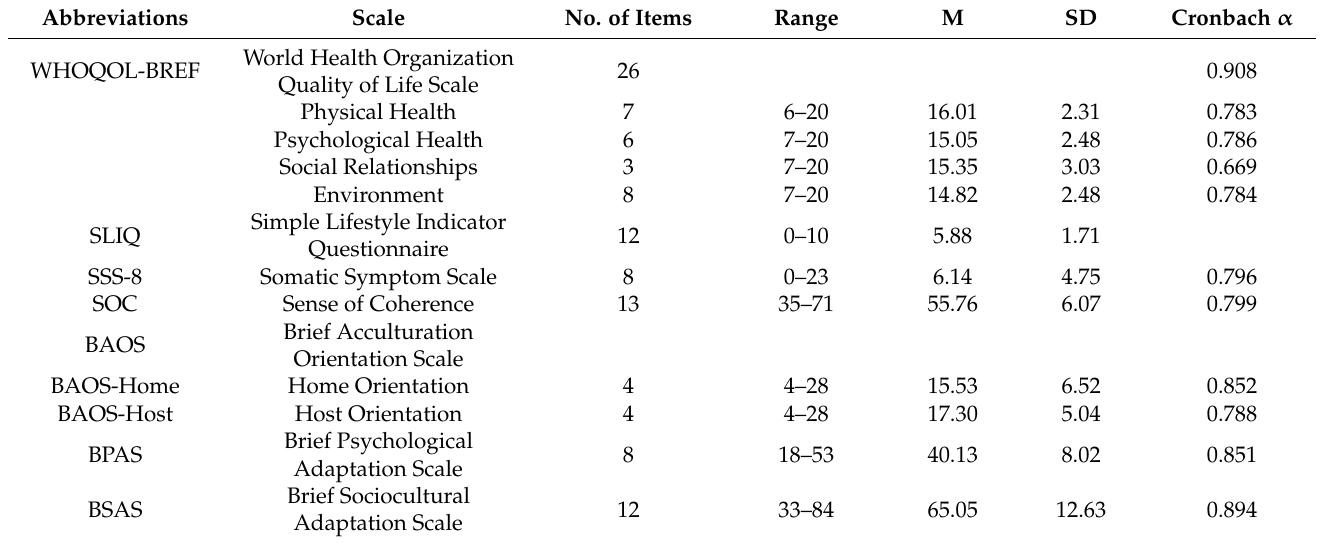
Table 3. Reliability coefficients of the